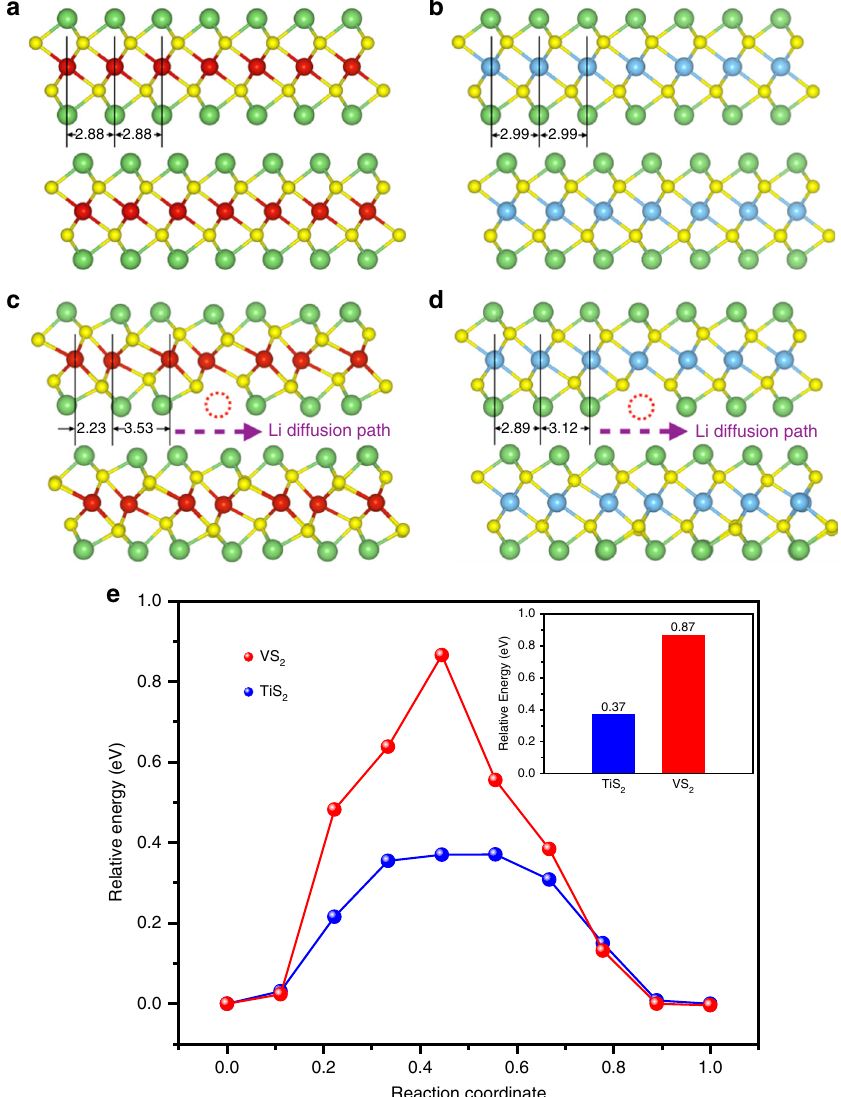
Fig. 5 DFT calculations. Fully intercalated pristine layered structures, a Li 2 VS 2 and b Li 2 TiS 2 . Here, the yellow and green balls symbolize sulfur and lithium atoms, respectively. Vanadium atoms are red and titanium atoms are blue. Lithium diffusion in these systems requires that a neighboring lithium site is vacant. The corresponding intercalated structures with Li vacancies, marked with dashed red circles are shown for c Li 2 VS 2 and d Li 2 TiS 2 . Lithium diffusion paths are indicated by purple arrows. Notice that the even spacing of 2.88 Å between vanadium atoms in fully intercalated Li 2 VS 2 distort to 2.23 and 3.53 Å when a lithium vacancy is introduced. The distortion is much smaller in Li 2 TiS 2 , for which the distances between titanium atoms distort from 2.99 Å to 2.89 Å and 3.12 Å. e Energy pro fi le along the lithium diffusion path in the VS 2 and TiS 2 (inset indicates the energy barriers for lithium migration). Reaction coordinates 0 and 1 correspond to the beginning and end of the lithium migration paths, which are equilibrium systems, while noninteger reaction coordinates in-between denote the fraction of the lithium migration path that has been traversed. DFT density functional